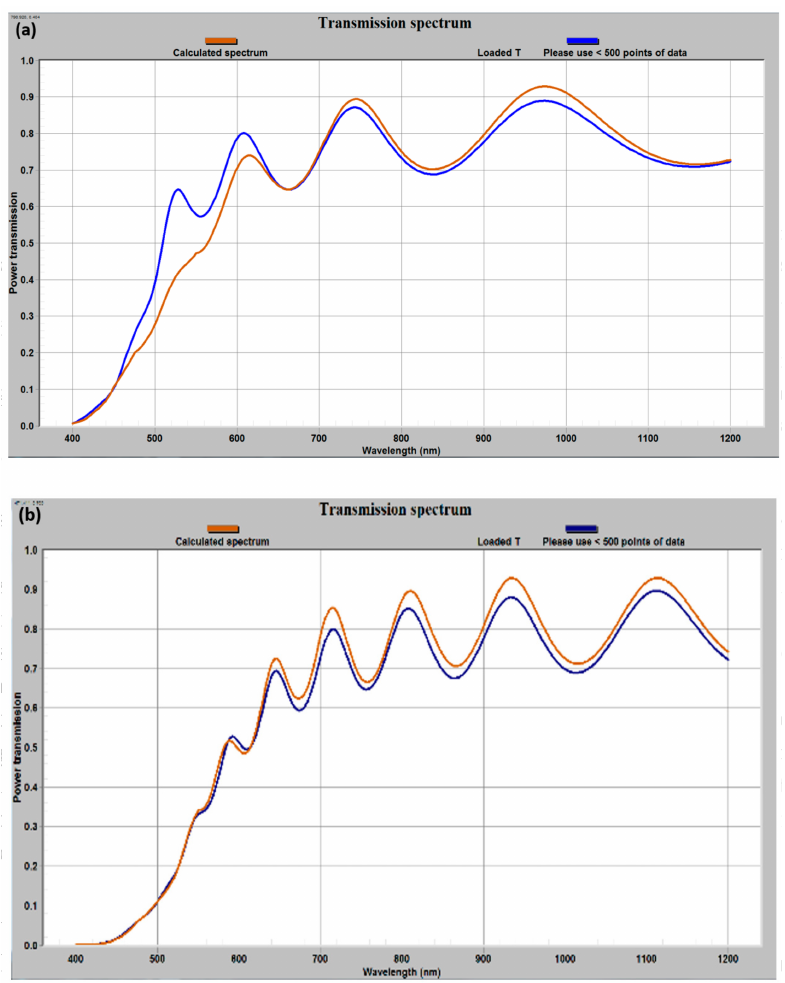
Figure 7. Magneto-photonic crystal (MPC) software fitted transmission spectra of di ff erent thin film garnet layers. ( a ) Annealed garnet sample of composition type Bi 0.9 Lu 1.85 Y 0.25 Fe 4.0 Ga 1 O 12 and thickness 684 nm and ( b ) as-deposited garnet sample of the same composition but from another batch and thickness 1310